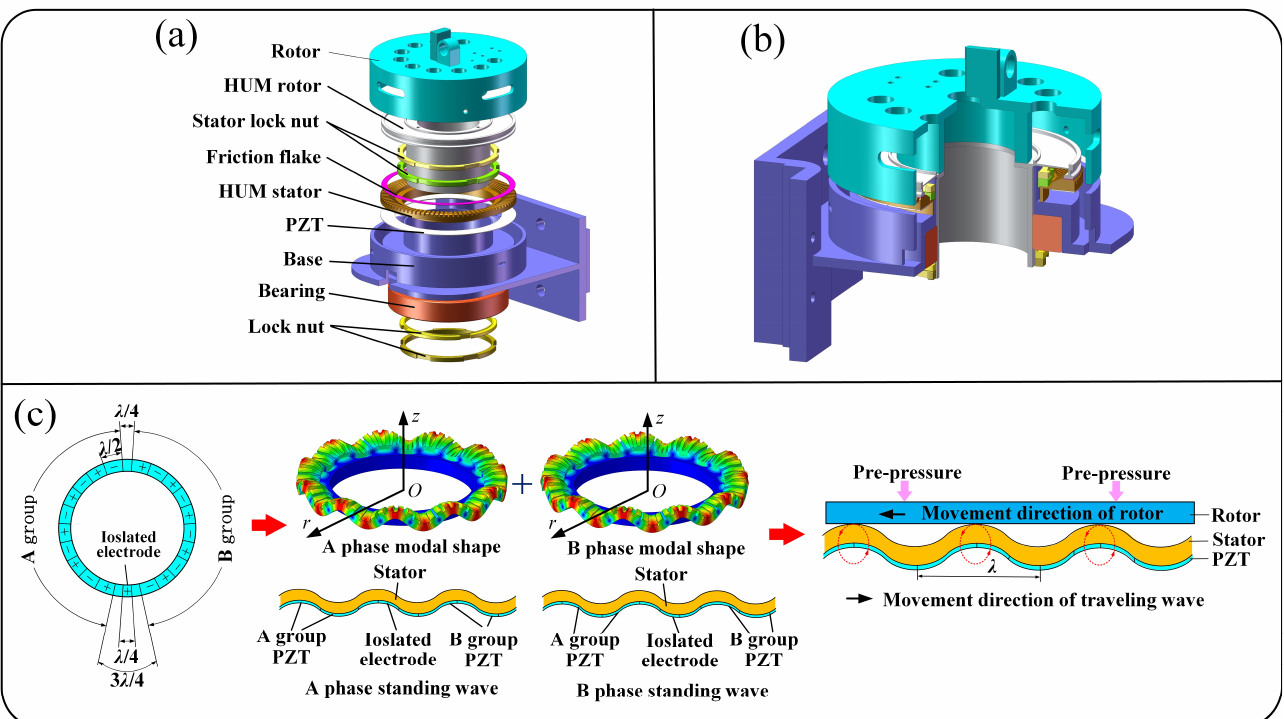
Figure 4. The explosion view ( a ) and section view ( b ) of the HUM. ( c ) The motion mechanism of the HUM.